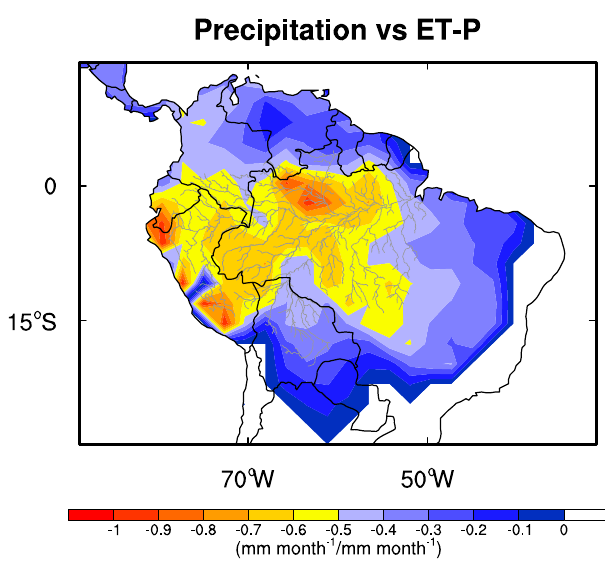
Fig. 5 The regression slope coef fi cient between the ET-P (mm month − 1 ) estimates based on TWS/discharge versus AIRS δ D _004 and GPCP precipitation (mm month − 1 ) during 2003 – 2015. Monthly ET-P estimates and precipitation values are used for the